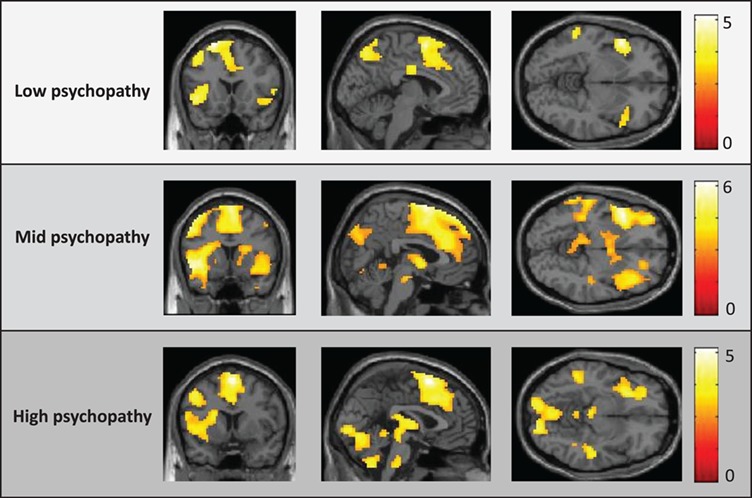
Neural activity within the NegINCREASE NegWATCH contrast for each of the low-, mid- and high-psychopathy groups. SPM thresholded at \documentclass[12pt]{minimal}
\usepackage{amsmath}
\usepackage{wasysym} 
\usepackage{amsfonts} 
\usepackage{amssymb} 
\usepackage{amsbsy}
\usepackage{upgreek}
\usepackage{mathrsfs}
\setlength{\oddsidemargin}{-69pt}
\begin{document}
}{}$P < 0.005$\end{document}, uncorr. for display purposes.